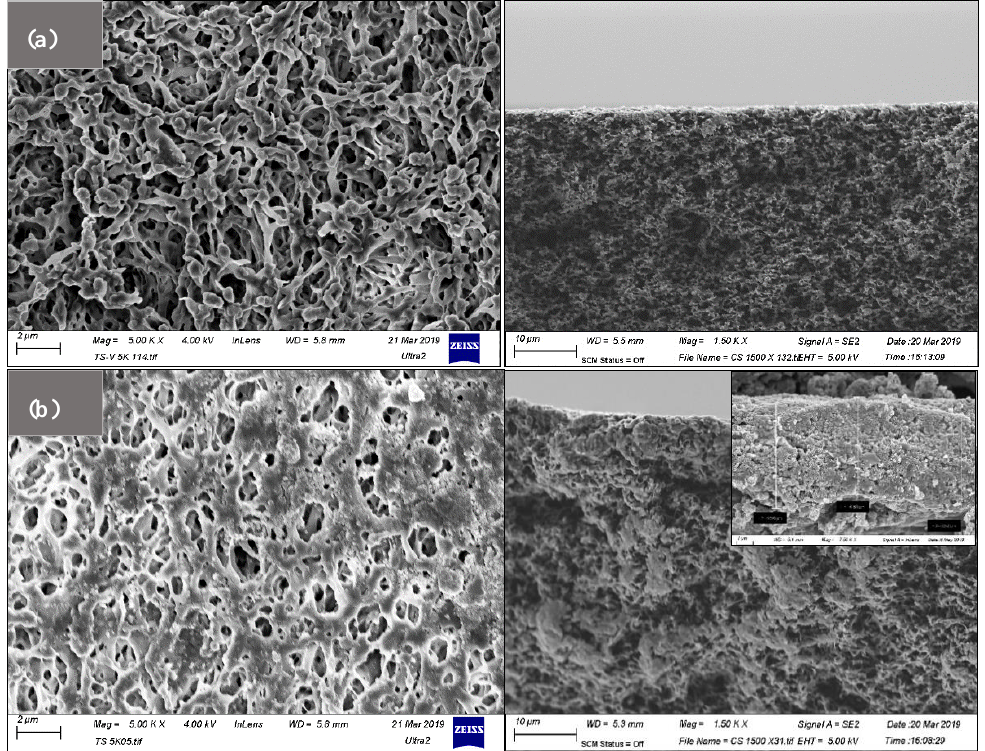
Figure 7. Top and cross-section morphology of ( a ) PVDF and ( b ) ZnO-MoS 2 membrane.